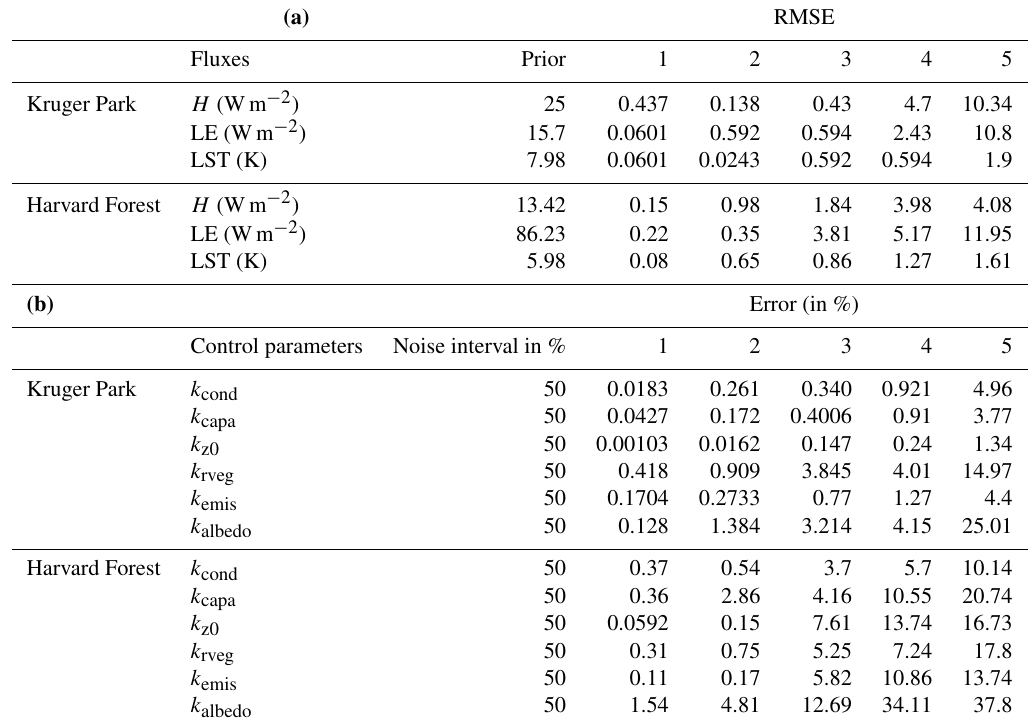
Table 6. Results of Experiment 1 using the Harvard Forest and Kruger Park sites. (a) The first two columns give the computed fluxes prior to the assimilation. The last five columns present the RMSE (prior-estimated) for each run. (b) The first two columns give the noise interval (in %) introduced for each control parameter with respect to the initial value of 1. The last five columns present the relative error in % in the control parameters for the five sampling frequencies reported in Table